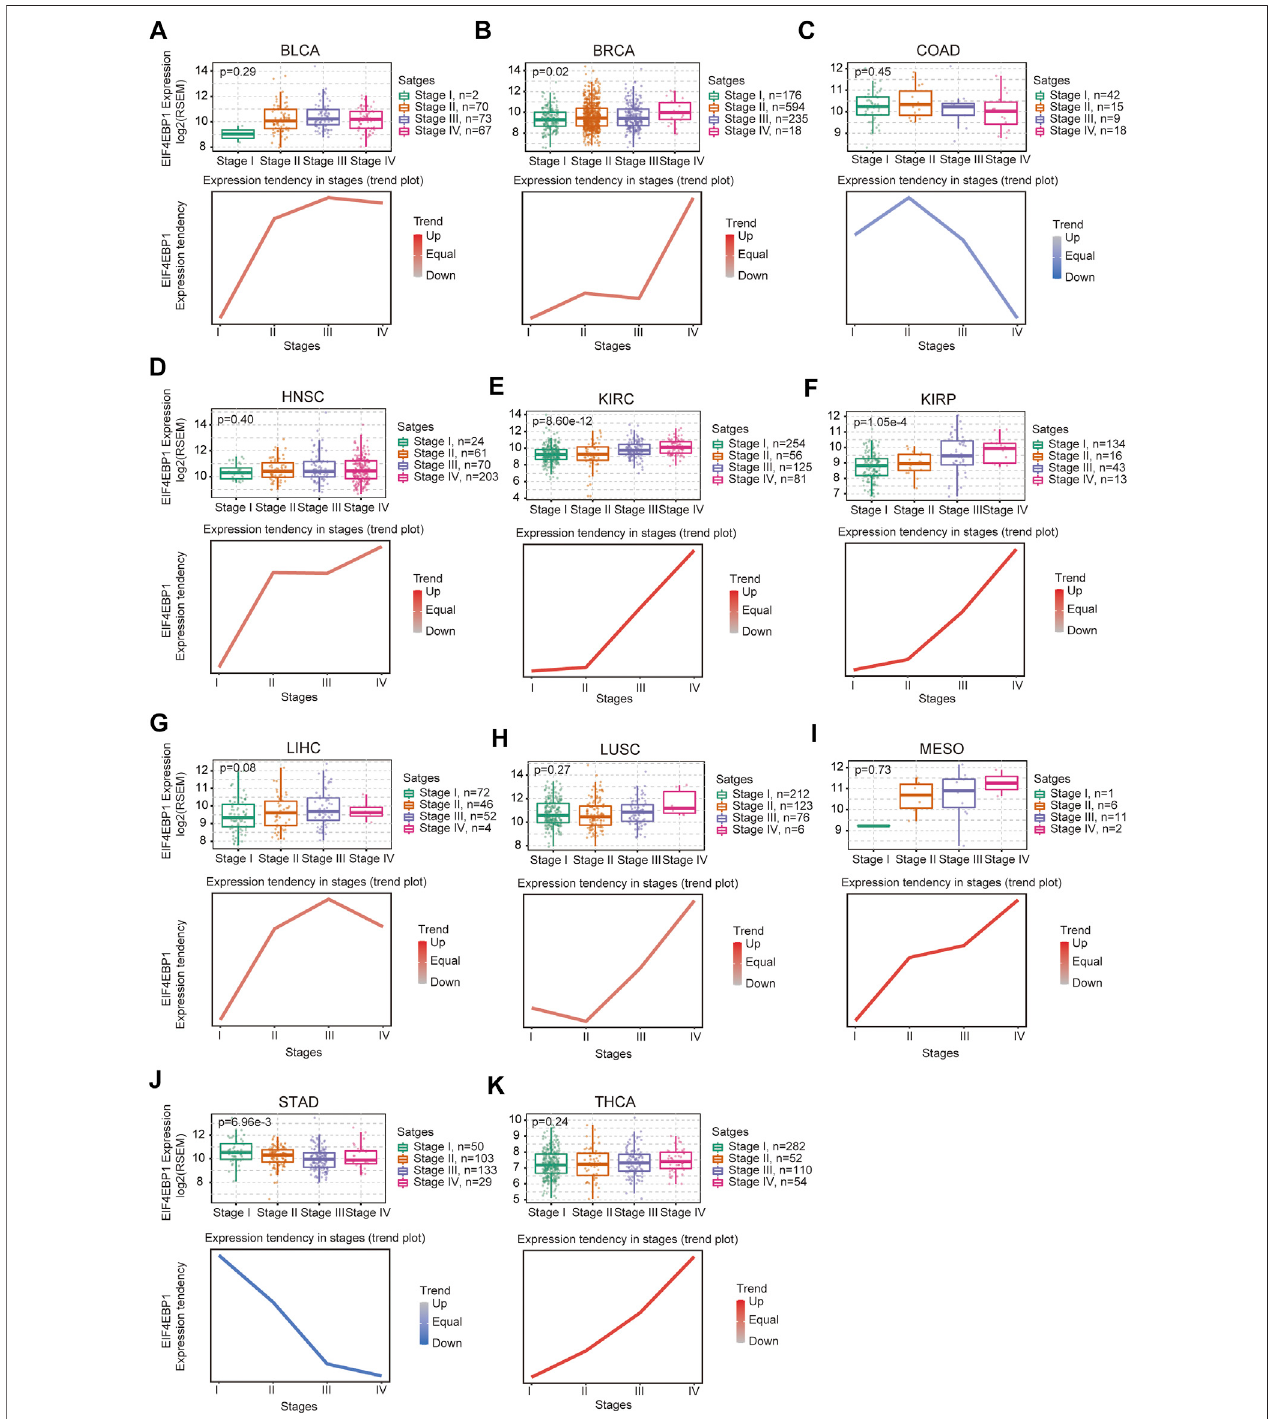
FIGURE 1 | Expression level and trend of 4EBP1 gene in different pathological stages. Based on the TCGA data, the expression levels of the 4EBP1 gene were analyzedbythemainpathologicalstages(StageI,StageII,StageIII,andStageIV)of (A) BLCA, (B) BRCA, (C) COAD, (D) HNSC, (E) KIRC, (F) KIRP, (G) LIHC, (H) LUSC, (I) MESO, (J) STAD, (K) THCA. Log2 (RSEM) was applied for log-scale.